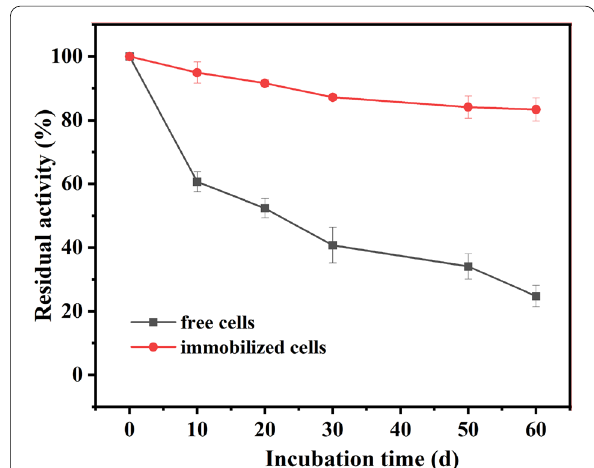
Fig. 4 Reusability of free and alginate‑immobilized recombinant Fig. 5 Storage stability of free and alginate‑immobilized E. coli cells. Reaction conditions: 4 mL Tris–HCl buffer (200 mM, pH recombinant E. coli cells at 4 ℃ . Reaction conditions: 4 mL Tris–HCl 7.0), 100 mM MAA, 150 mM glucose, 30 mg/mL of free recombinant buffer (200 mM, pH 7.0), 100 mM MAA, 150 mM glucose, 30 mg/mL E. coli cells (wet weight), or immobilized cells containing the same of free recombinant E. coli cells (wet weight), or immobilized cells amount of free cells, 40 ℃ , 200 rpm. ( n 3, different lowercase letters containing the same amount of free cells, 40 ℃ , 200 rpm = represent significant differences between groups, p < 0.05)